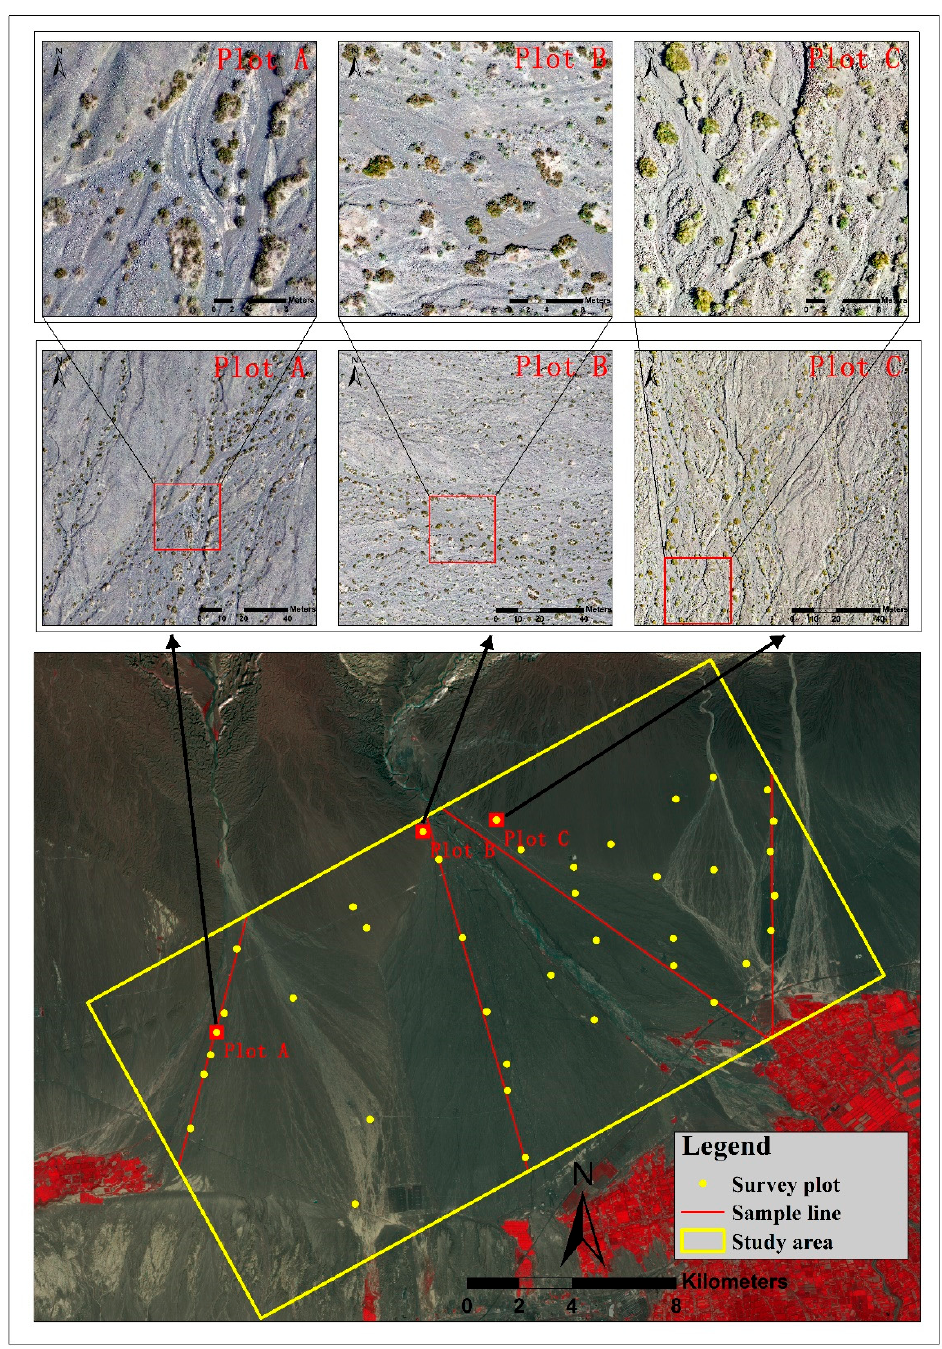
Figure 2. Unmanned aerial vehicle (UAV) images processing of shrub vegetation alliances used for shrub species classification experiments and the sampling plots within the study area.